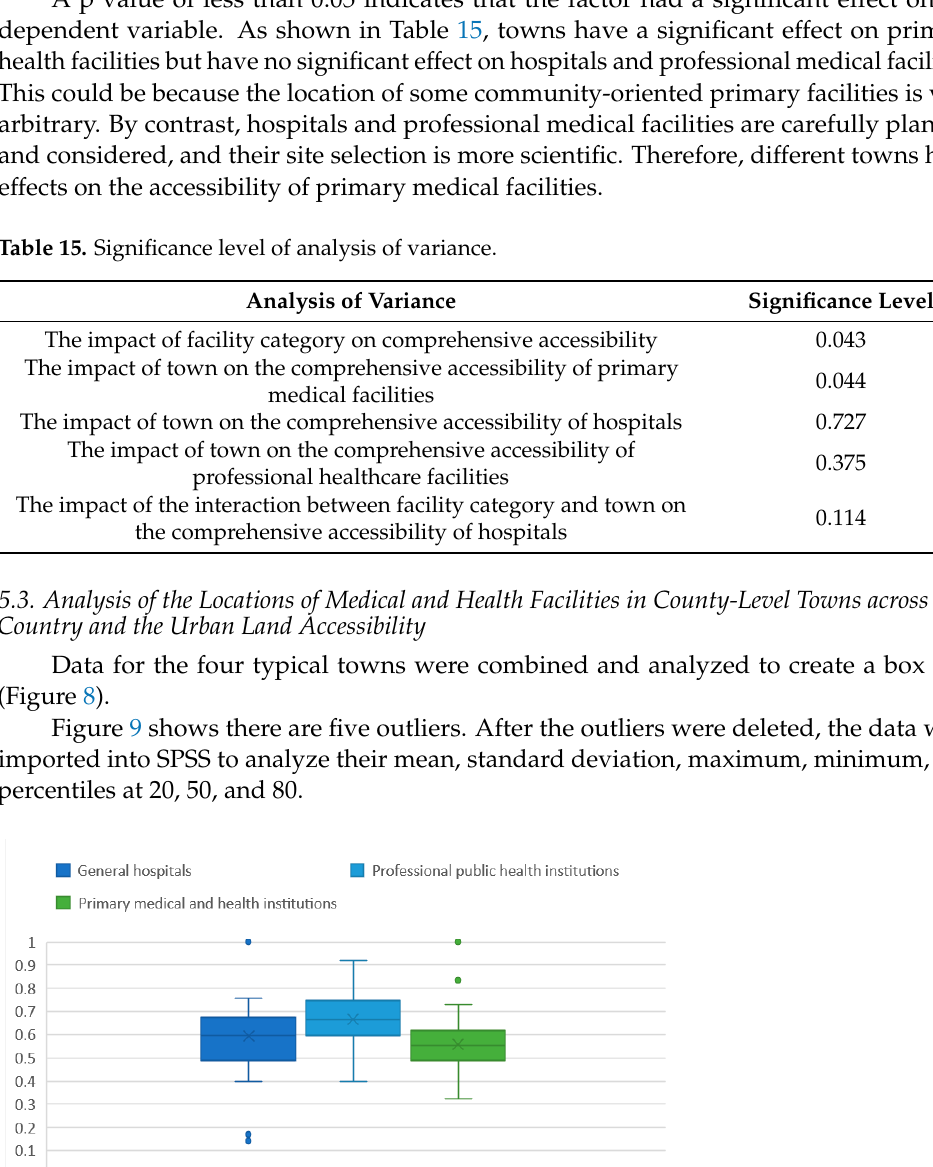
Table 15. Significance level of analysis of variance.